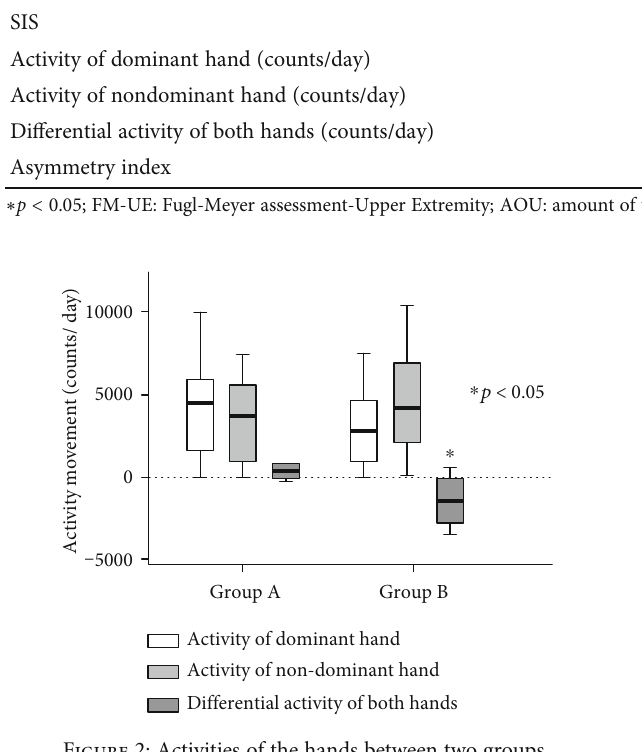
Figure 2: Activities of the hands between two